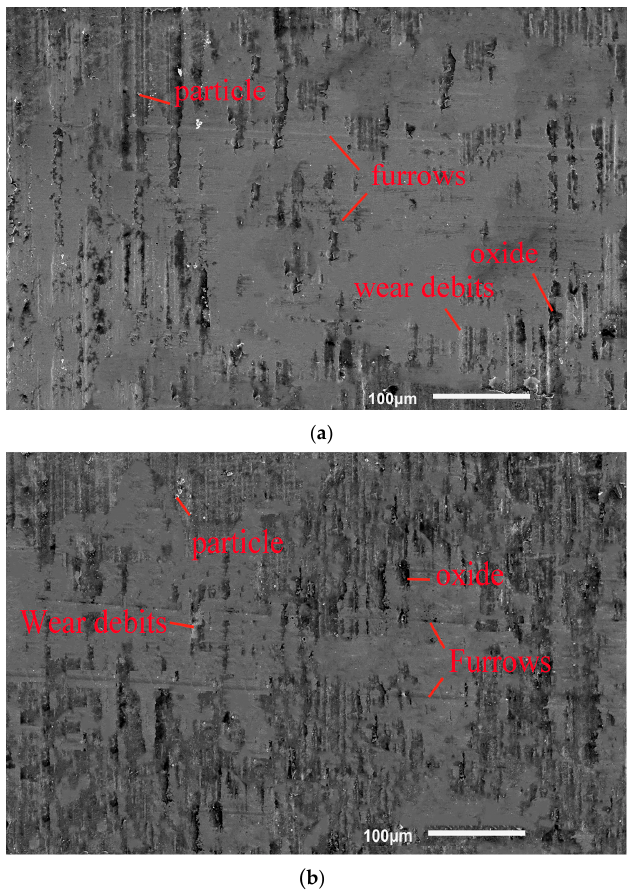
Figure 11. The wear surface morphology of the hardened layer under high temperatures. ( a ) The hardened layer at 110 °C. ( b ) The hardened layer at 200 °C